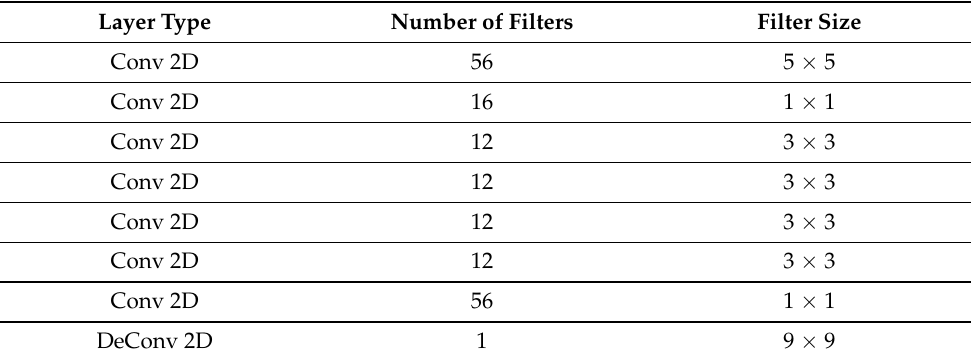
Table 2. The architecture of the neural network used for super resolution. Layer